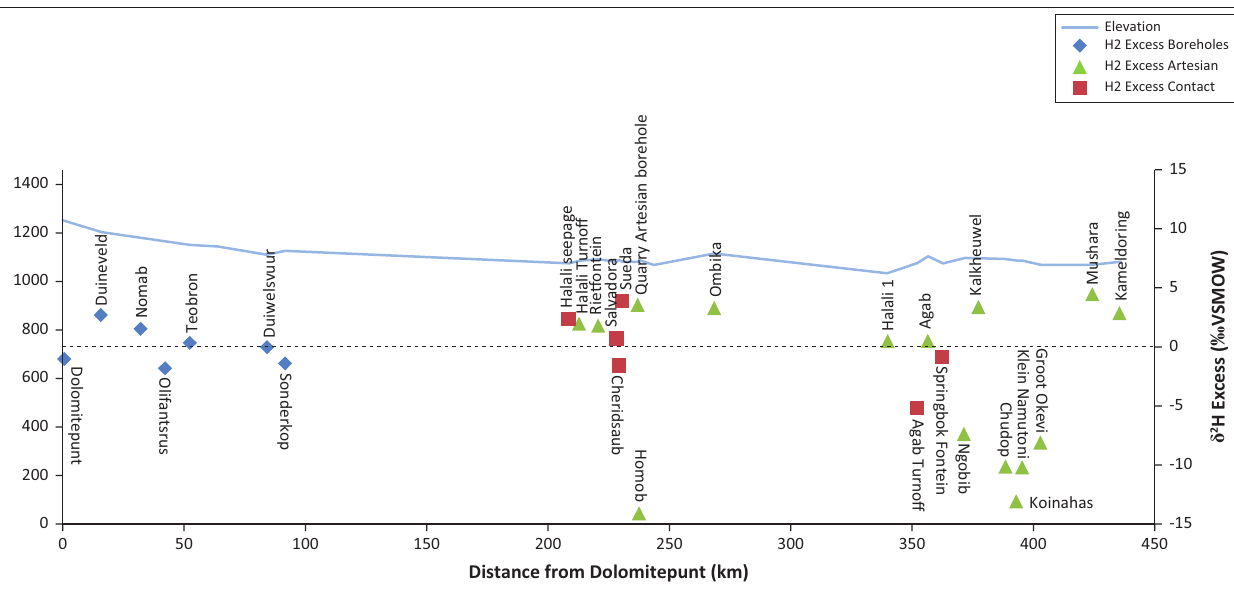
FIGURE 3: Variation of altitude, δ 2 H and δ 18 O (above) and δ 2 H excess (below) along an approximate east-west transect for different water point types in the Etosha National Park, May 2013, with altitude reference.